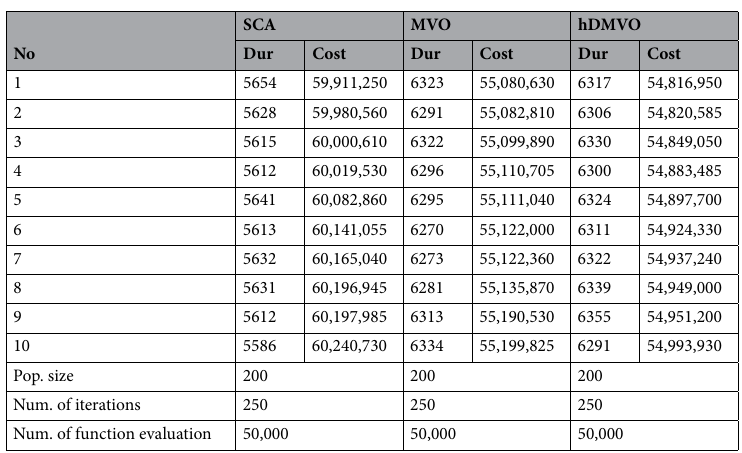
Table 12. Analysis results of problem 630a.